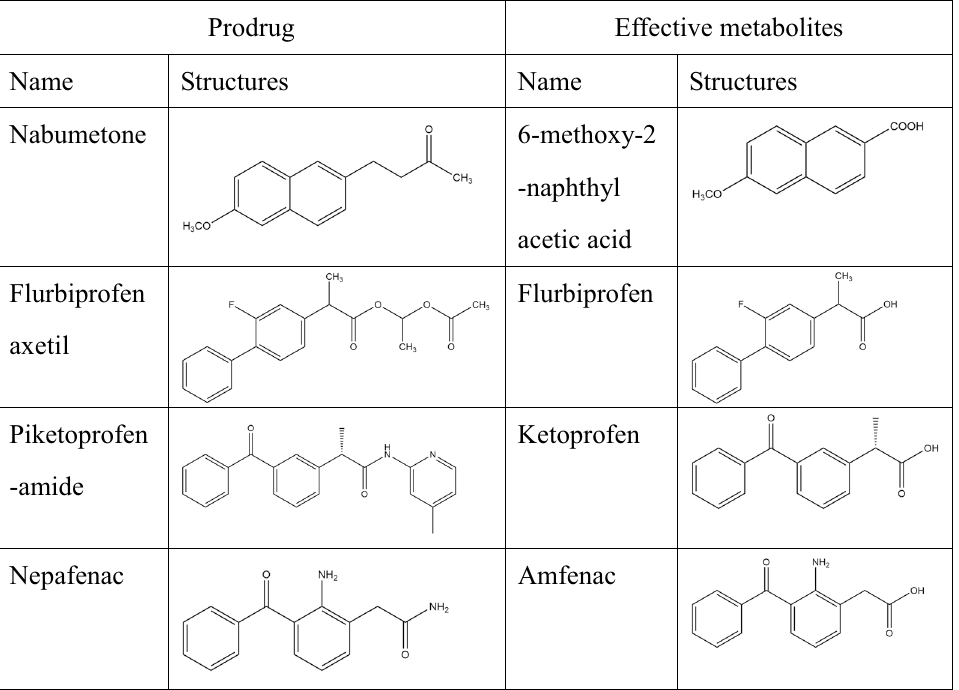
Table 2 Structures of ester prodrugs obtained by inhibiting COX-2 and effective